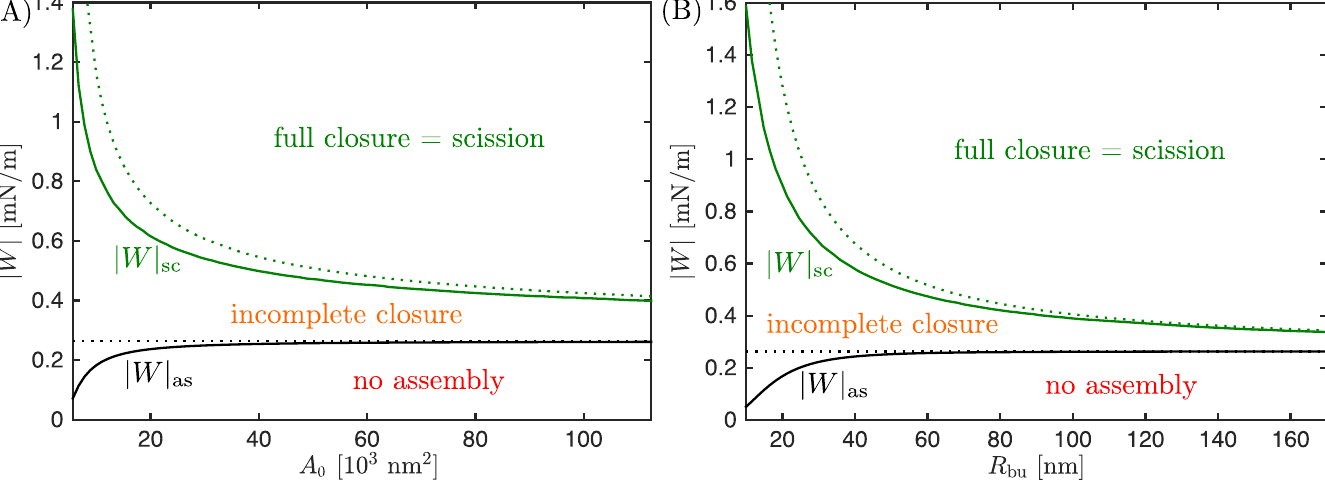
ffiffiffiffiffiffiffiffiffiffiffiffiffiffiffi p j W j = 2 k